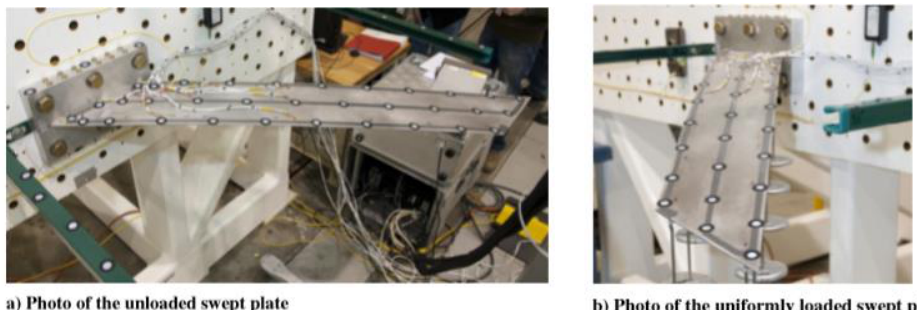
Figure 10. Photos of the wing-like swept plate experiments with three lines of FBG sensors (property of the NASA Dryden Flight Research Center)